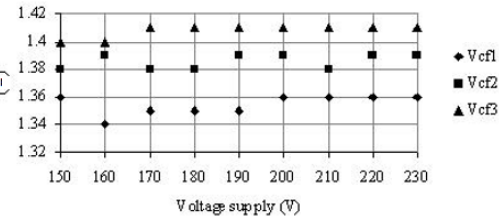
Figure 2. Crest factors V cf 1 , V cf 2 , and V cf 3 for the phase voltages a , b , and c depending on the supply voltages (set 1).